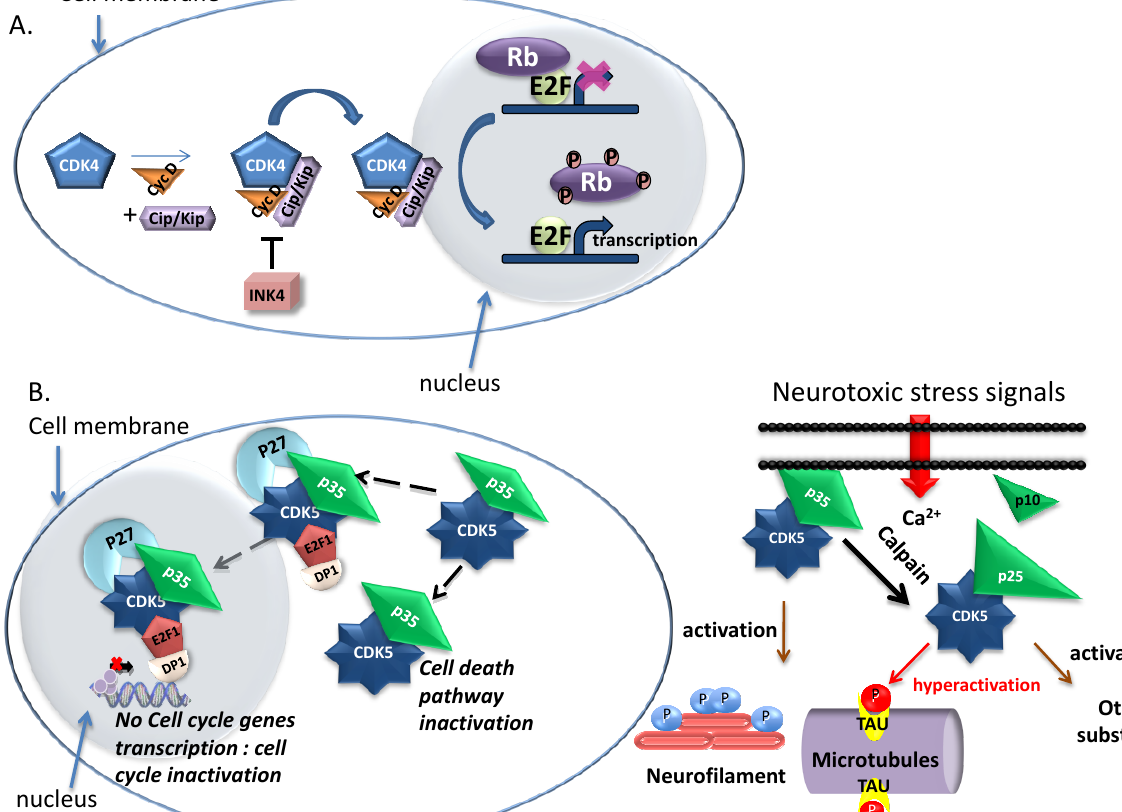
Figure 2. Functions of CDK4/Cyclin D and CDK5/p25. ( A ) Function and regulation of CDK4/cyclin D: The expression of cyclin D (orange) via mitogenic signals leads to its association with CDK4 (blue) and formation of the complex. The binding with Cip/Kip proteins (light purple) is required for complex assembly and its nuclear localization. The activity of CDK4/cyclin D activity is negatively regulated by interaction with the INK4 protein family (pink). Once activated, CDK4/cyclin D regulates the progression through G1 phase and the transition into S phase. CDK4/cyclin D phosphorylates the retinoblastoma protein (Rb) (dark purple) inducing the derepression of E2F transcription factors (green) which allows the transcription of genes which are required for G1/S transition; ( B ) Different functions of CDK5 in the nervous system and schematic representation of CDK5 regulation through cleavage of p35 to p25 at the cellular membrane; when CDK5/p35 binds p27 and E2F1 and DP1 in the nucleus, the cell cycle is inactivated. When p27 is degraded CDK5/p35 returns to the cytoplasm and the cell death pathway is